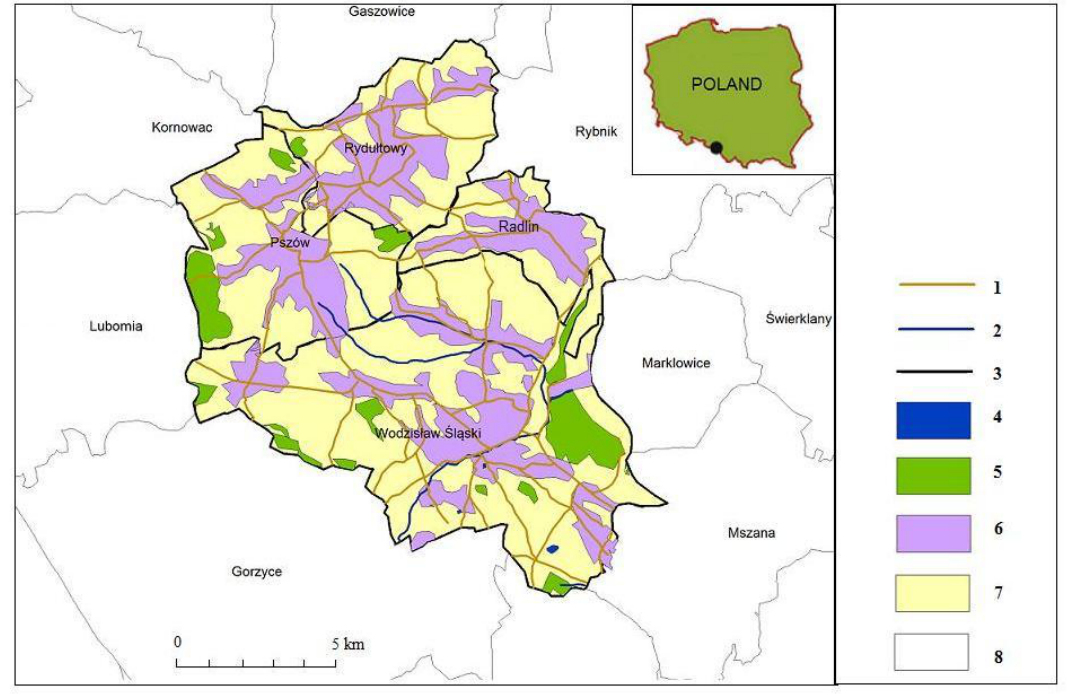
Fig. 1. Study area on the background of using of